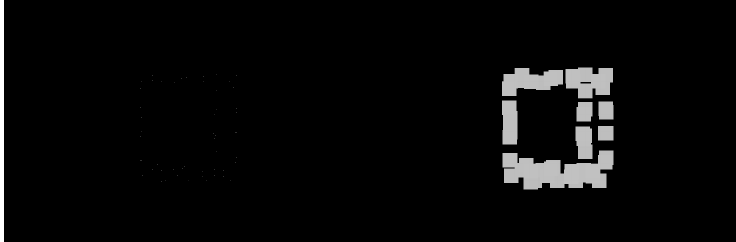
Figure 3. Dilation over the sparsed 2D points.